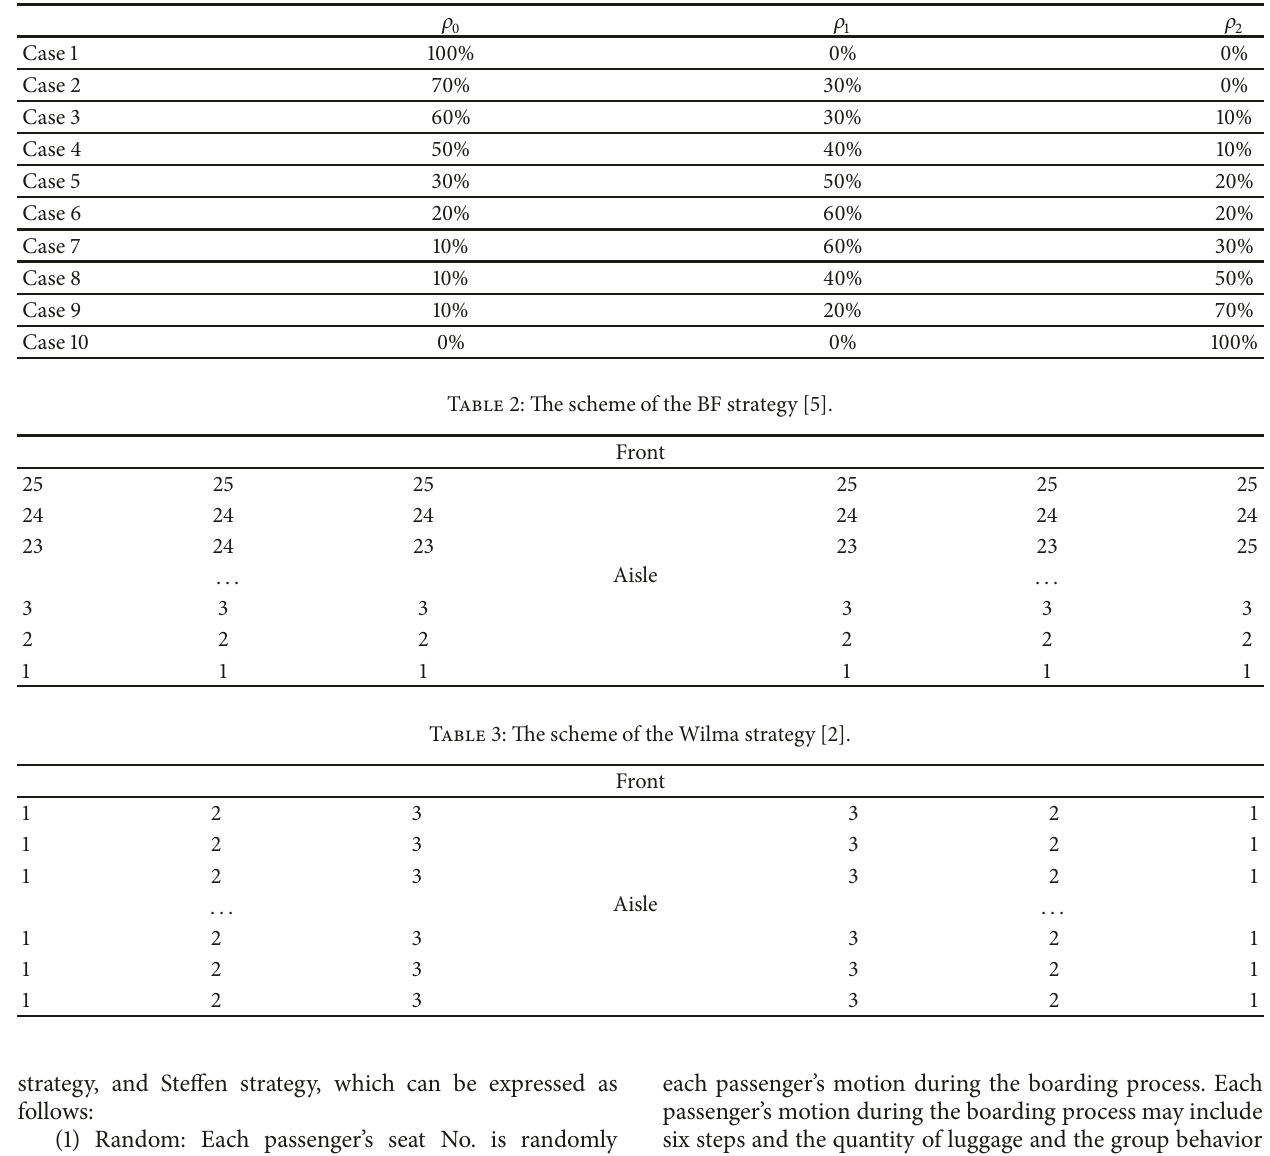
Table 1: The distributions of the quantity of luggage.